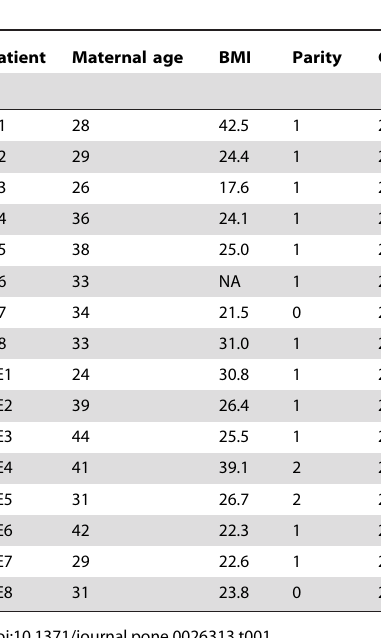
Table 1. Patient